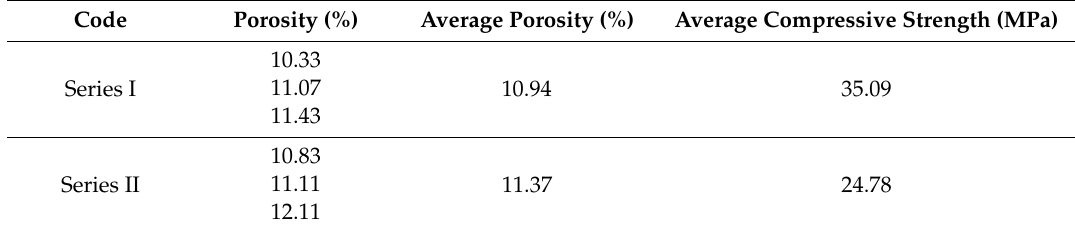
Table 7. Porosity test of geopolymer concrete